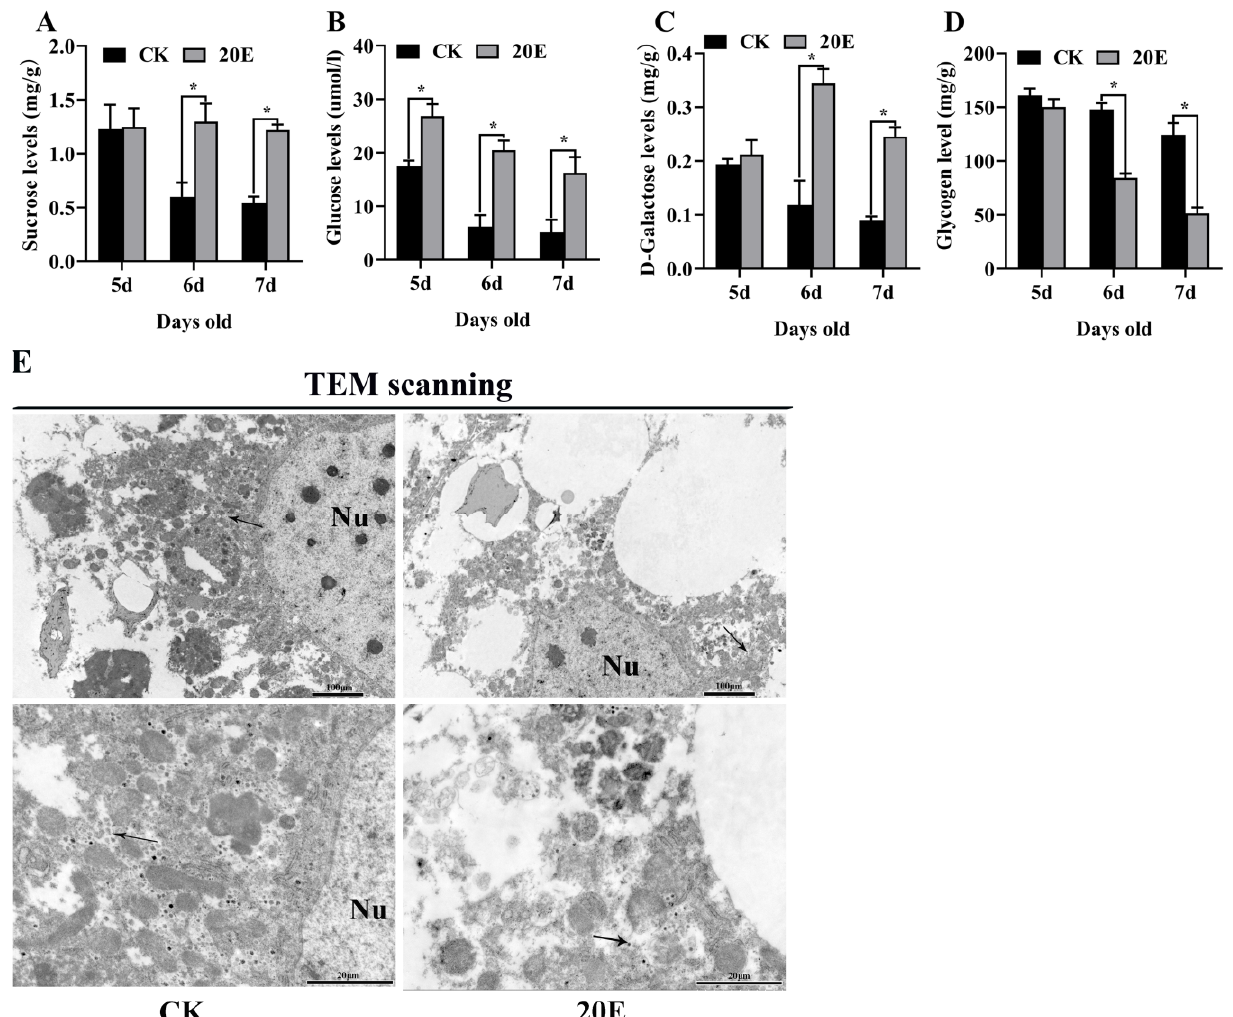
Figure 7. 20E increased hemolymph glucose, sucrose and D-Galactose levels during metamorphosis. ( A ) The hemolymph sucrose levels during development; ( B ) the hemolymph glucose levels during development; ( C ) the hemolymph D-Galactose levels during development. Bee Ringer solution was used as the solvent control. ( D ) Glycogen levels in the fat body. ( E ) TEM observation after infection with 20E in the fat body. The arrow represented the glycogen particles. Nu: nucleus. The error bars indicate the mean ± SEM of three times repetition. The asterisks indicate significant differences from the control group (*, p < 0.05) by using the Student’s t- test.